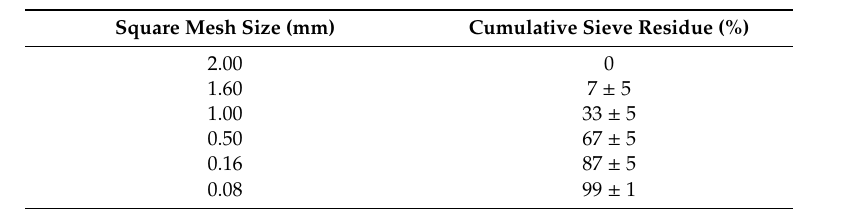
Table 2. Particle size distribution of the standard quartz sand